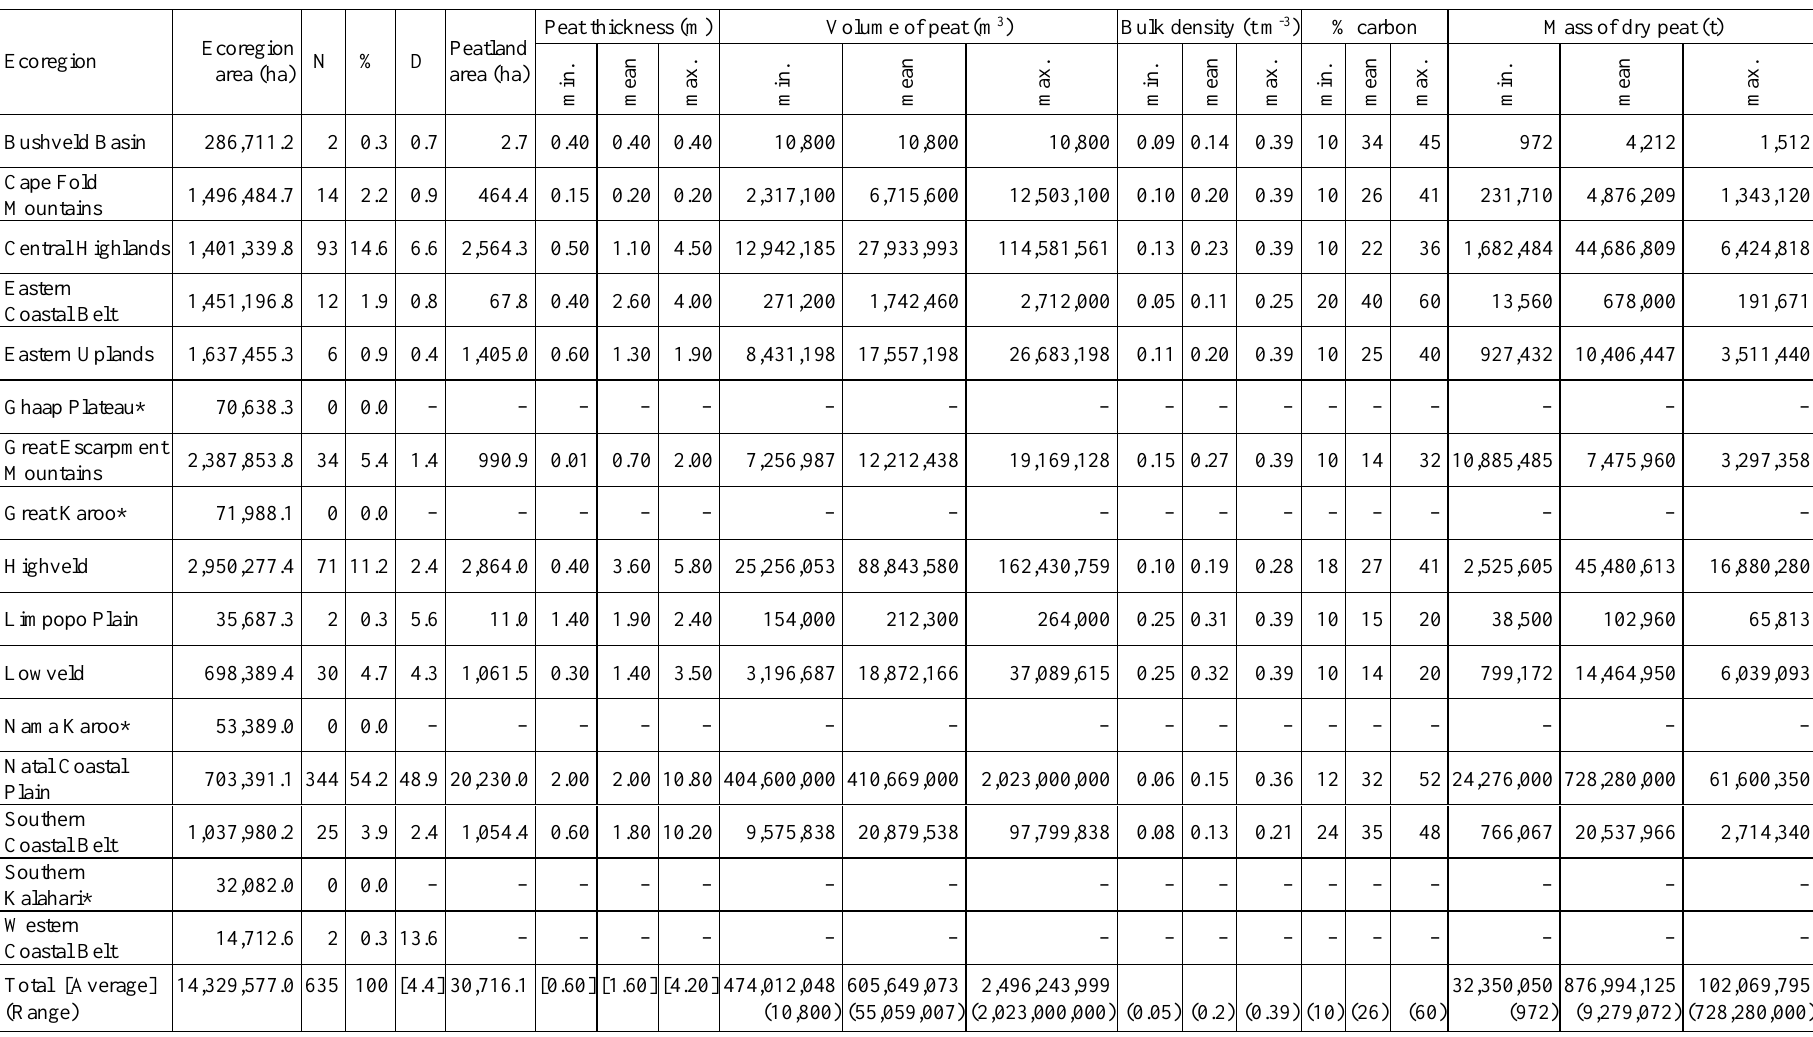
Table 1. Summary statistics per peat ecoregion, derived from 635 South African peatland samples (adapted from Grundling et al. 2017). N = number of samples; % = % of sampled points; D = density (points ha -1 × 10 5 ); min. = minimum; max. = maximum. Asterisks (*) indicate peat ecoregions with no verified peat sample points. Ecoregion Ecoregion Bushveld Basin Cape Fold Mountains